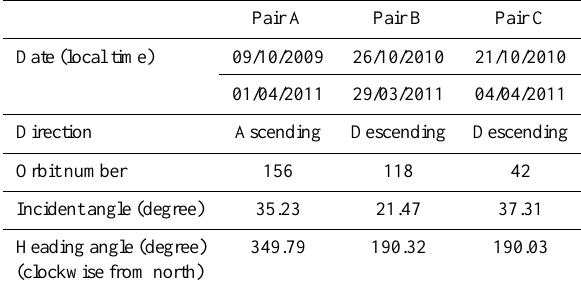
Table 1. Acquisition conditions of six pre- and post-event TerraSAR-X data used in this study.